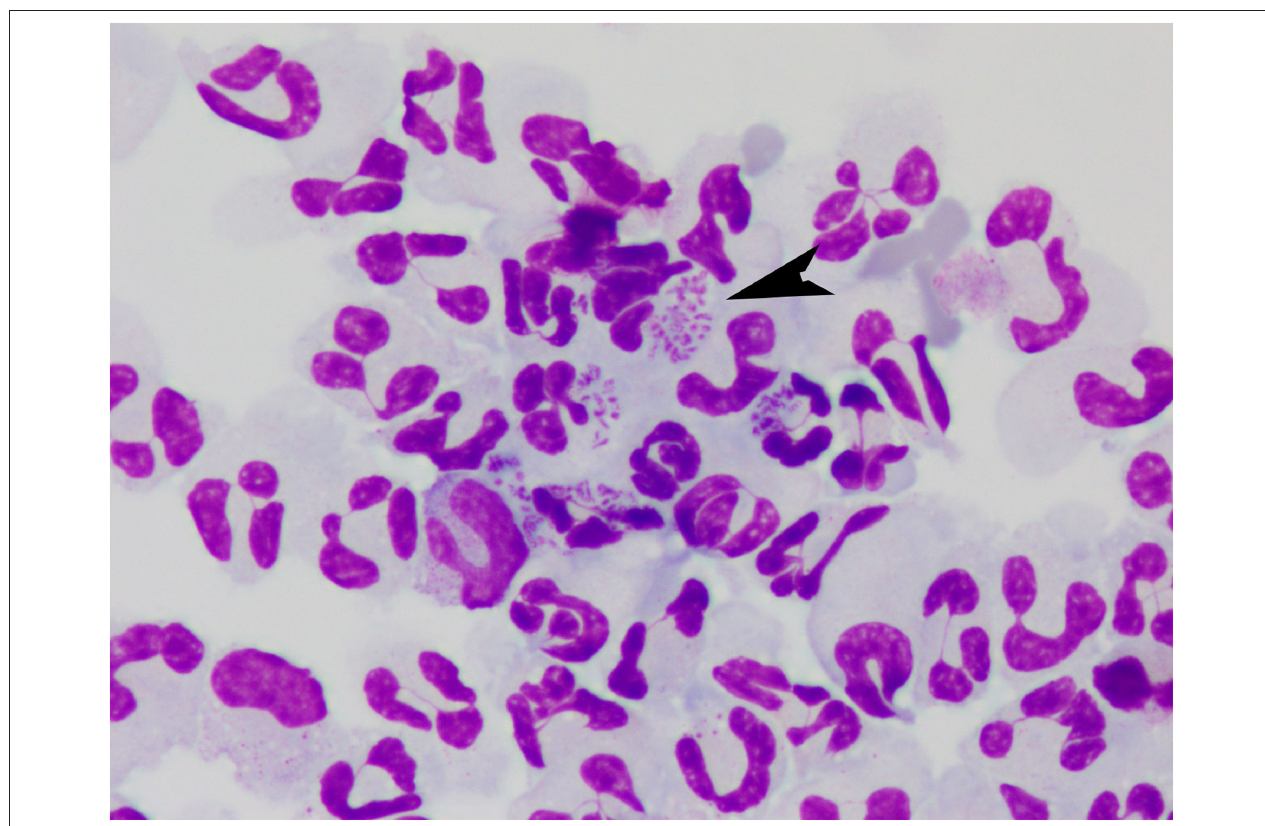
FIGURE 1 | Cerebrospinal fluid from a dog with Bordetella bronchiseptica meningoencephalomyelitis. Note the intracellular bacteria (arrow). Modified Wright-Giemsa 1000X.